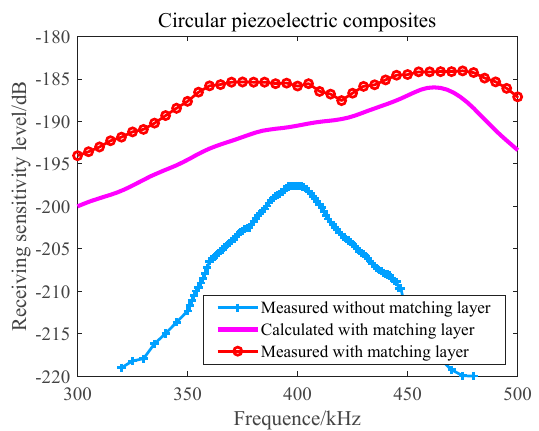
Figure 18. Directionality of a 390 kHz Circular Receiving Array.